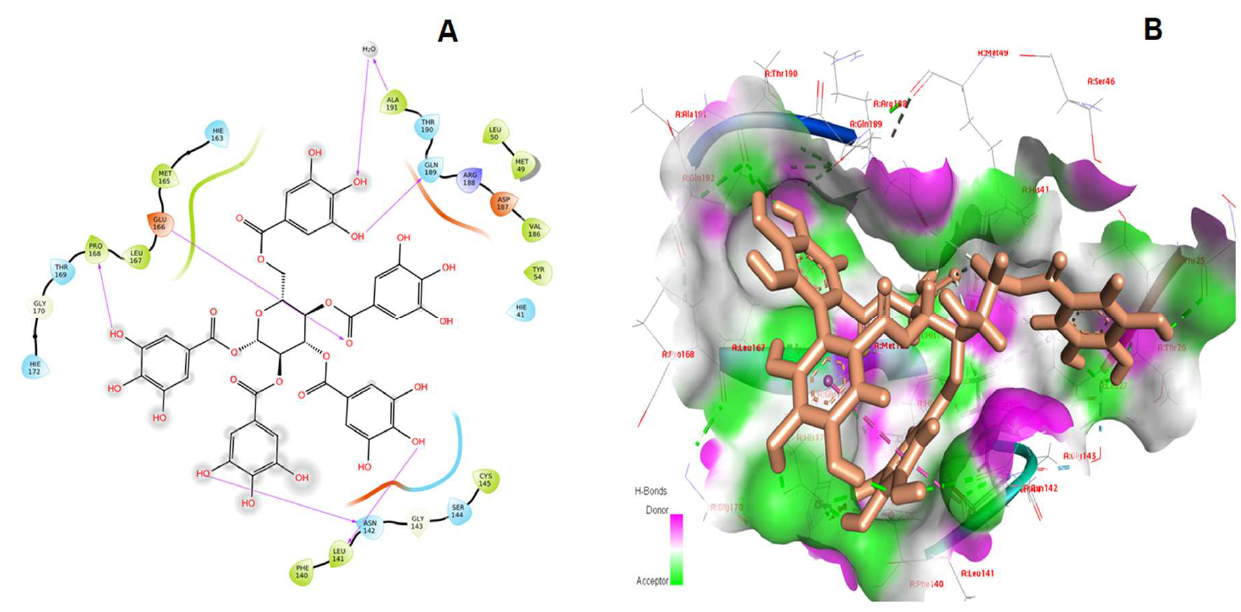
Figure 2. ( A , B ) Illustrations of the interaction between PGG and the target M pro protein of SARS-CoV-2. Shephagenin B interacts with Thr26, Phe140, Asn142, Glu166, Pro168, Gln189, and Thr190 after docking with the M pro. . Shephagenin B, found in Shepherdia argentea leaf extract, is a member of the tannin family. According to research, it acts as an antiviral component against the human immunodeficiency virus (HIV) [75]. Figure 3C,D show the interaction between Shephagenin B and the target M pro protein of SARS-CoV-2.